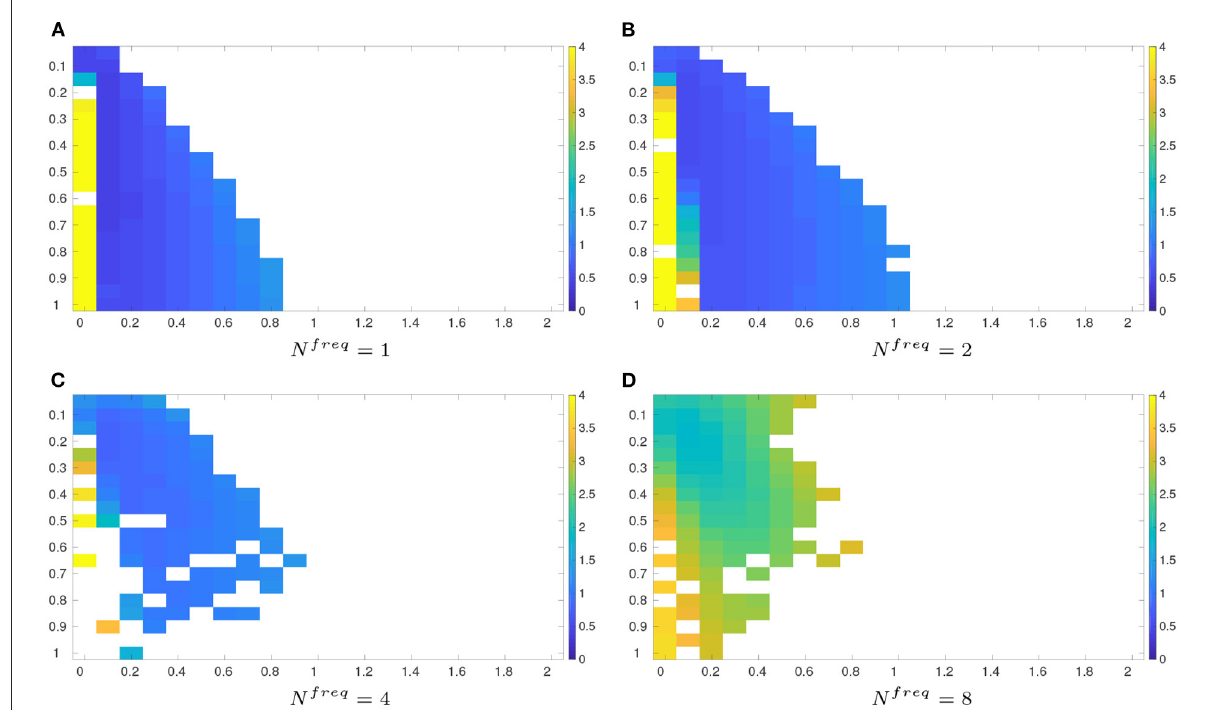
FIGURE3 As in Figure 1, but for average RMSEs obtained by the grid search method in the half observation scenario, with the same ensemble sizes N e 30 yet different observation frequencies. For ease of comparison, the results of the half observation scenario ( 1 n = in Figure 2 are re-plotted here. (A) N